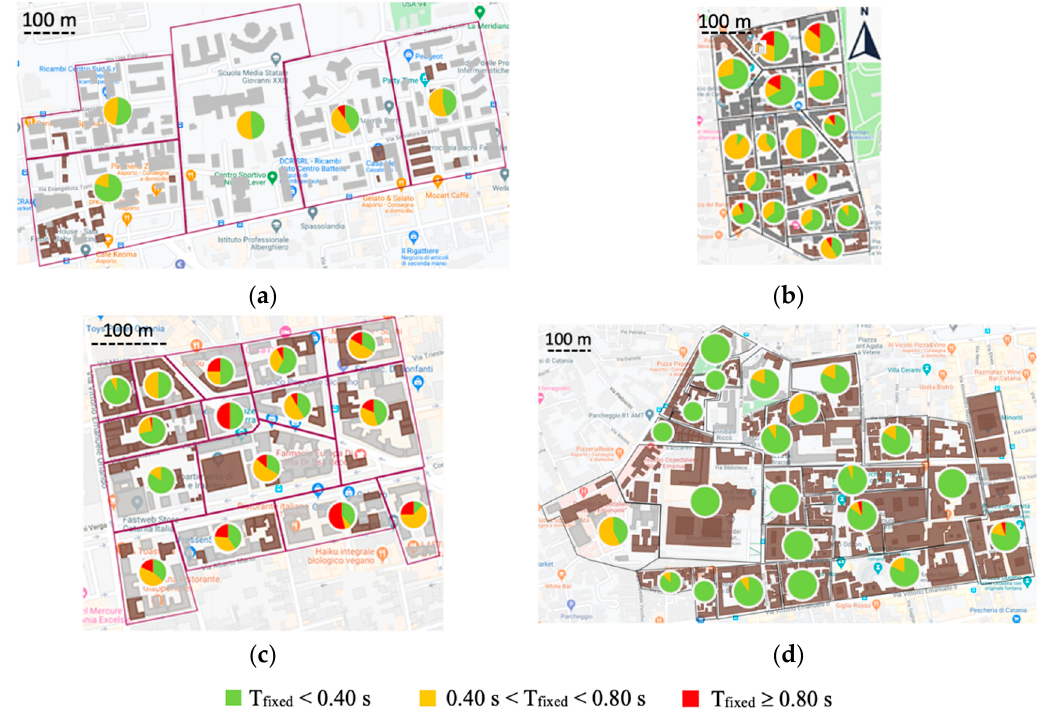
Figure 8. Spatial distribution of T fixed for the investigated areas: ( a ) west area; ( b ) northeast area; ( c ) north Old Town; ( d ) south Old Town.